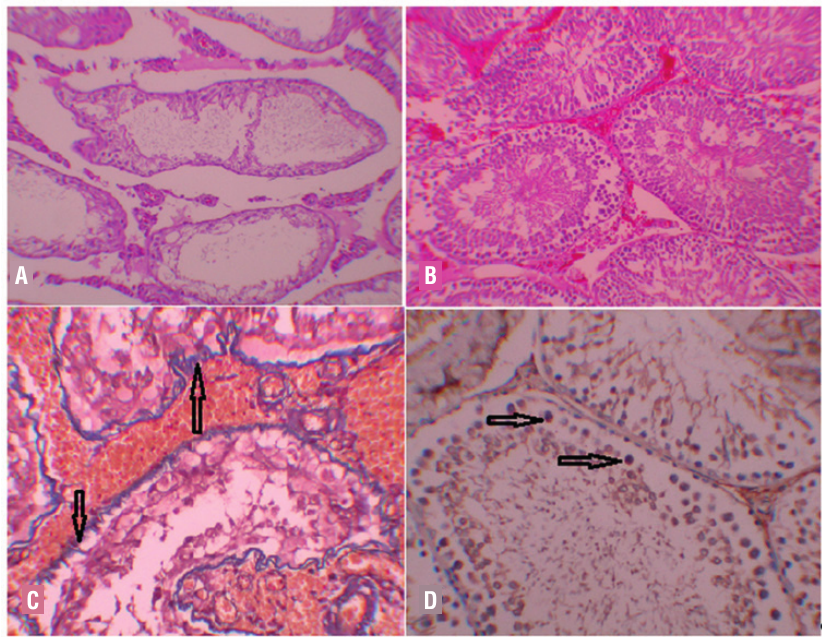
figure 1 A) I/R group, Left testis: Irregular contours, seminiferous tubules that only contain Sertoli cells and spermatogonia (H-E x100). B) DpO/Td combination Group, Left Testicle: Tubules on a hyperemic background, Johnsen score partially low, but organized tubules (H-E x100). c) I/R Group; Left Testicle M-T: Diffuse fibrosis in basal membrane of deformed seminiferous